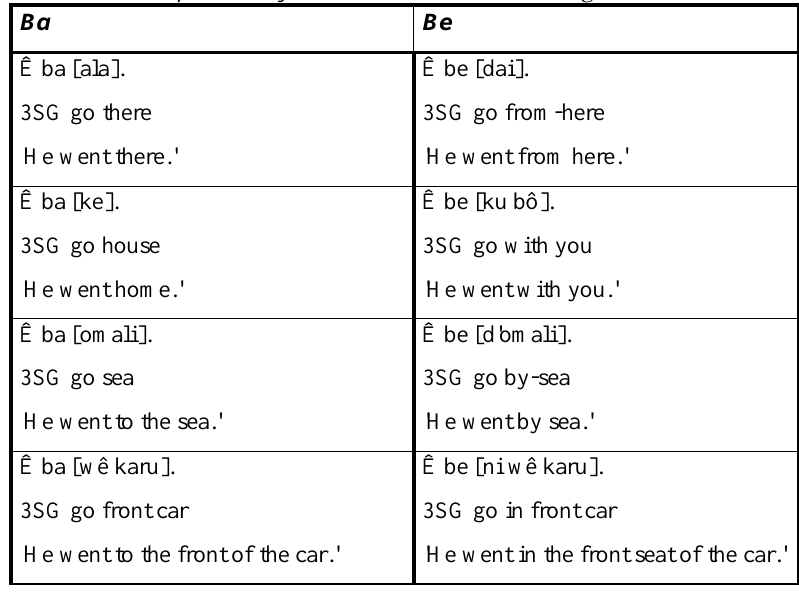
Table I. Complementary distribution of ba and be ‘to go’